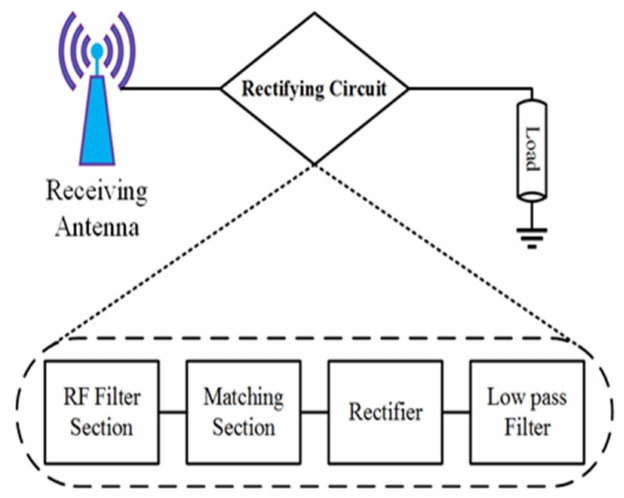
Figure 11. Multi-frequency RF harvesters design with elementary details in rectifier